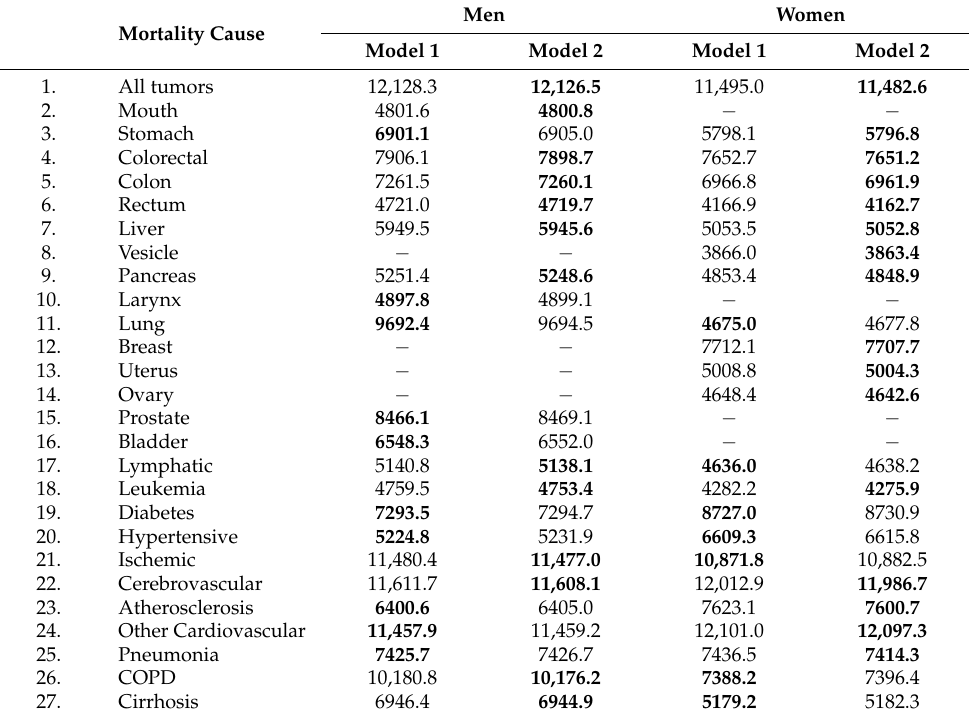
Table 3. DICs for each model and data set. Model 1 refers to the original AR model and Model 2 to the new model proposed in this paper. In order to facilitate comparisons, the lowest DIC in each case is highlighted in